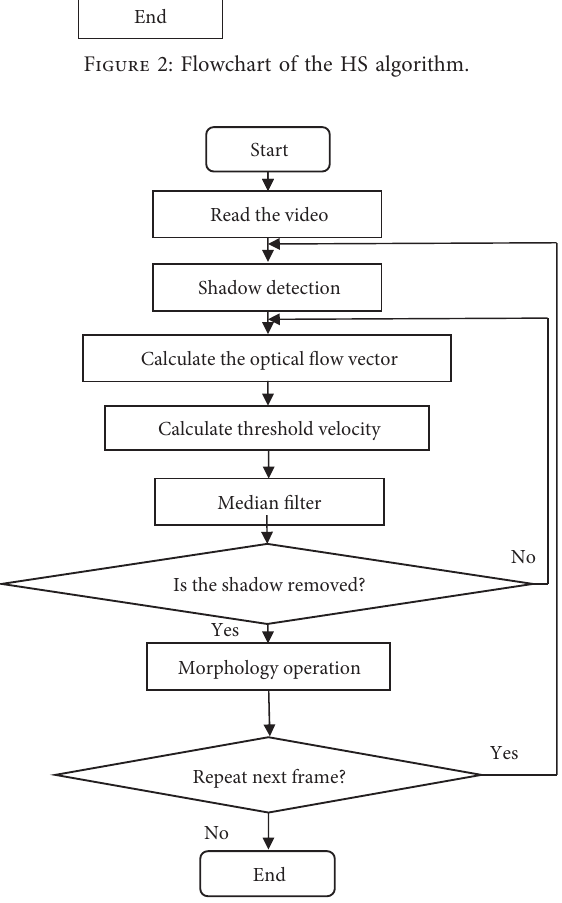
Figure 3: Flowchart of the improved algorithm.